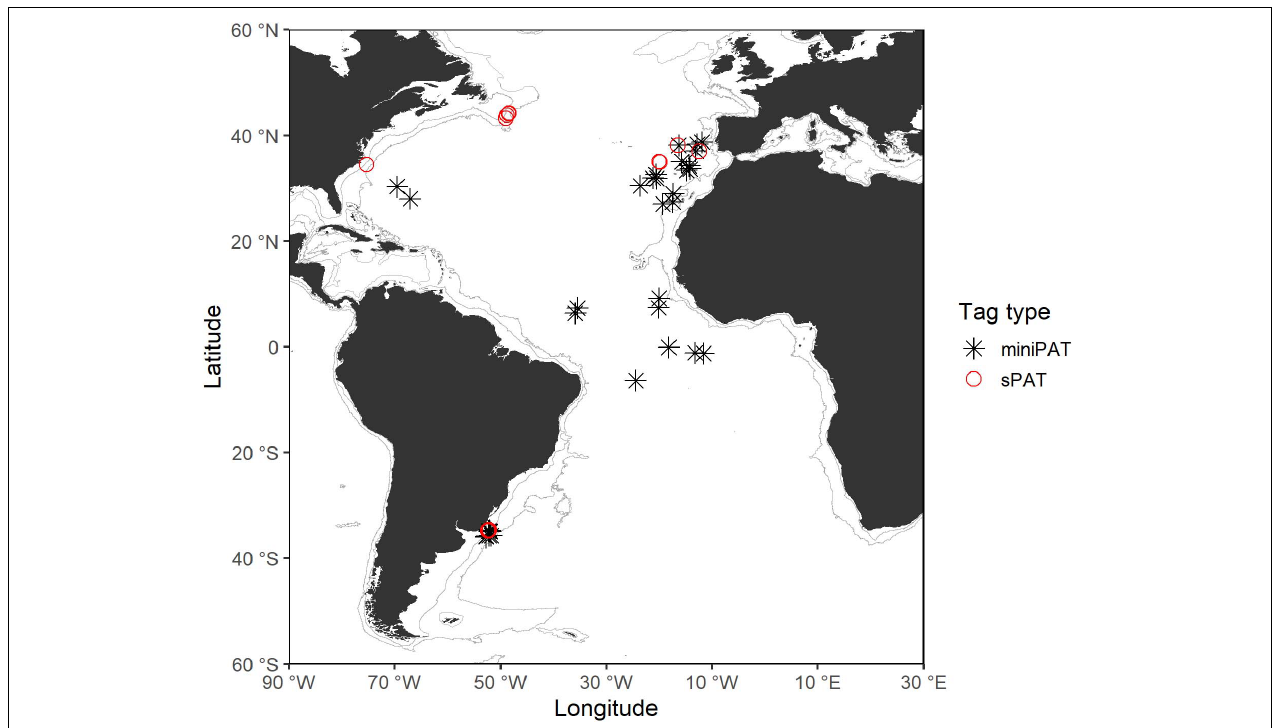
FIGURE 1 | Tagging locations of shortfin makos tagged with PSATs in the Atlantic Ocean during this study. Gray lines represent the boundaries of continental and insular margins (140–3,500 m